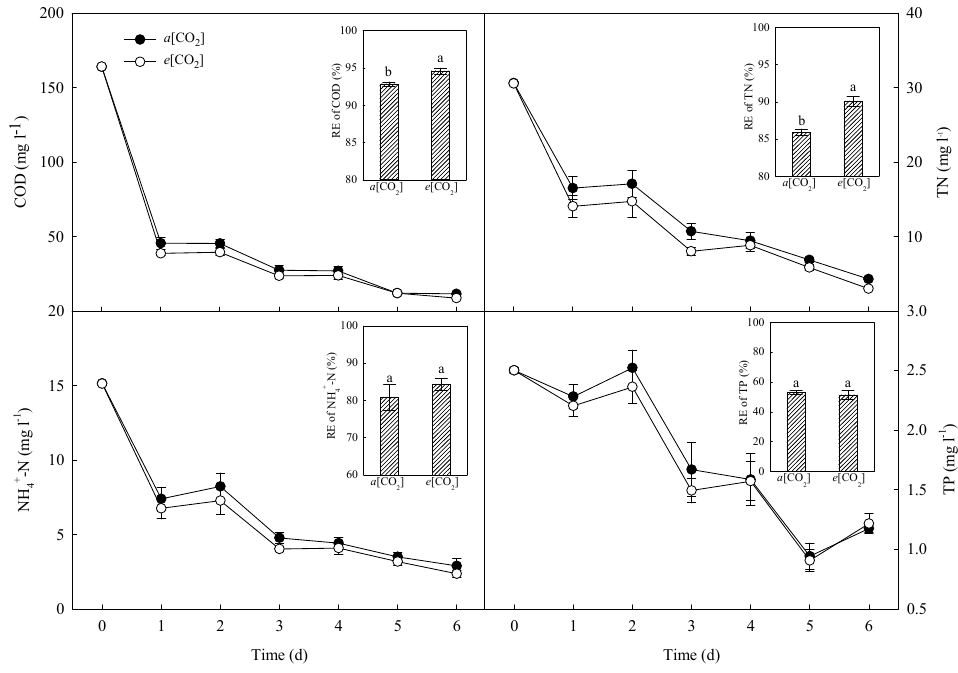
Figure 6. Effluent concentrations and removal efficiency (RE) of chemical oxygen demand, ammonia nitrogen, total nitrogen, and total phosphorus in the constructed wetlands on six consecutive days under ambient ( a [CO 2 ], 400 ppm) and elevated ( e [CO 2 ], 800 ppm) atmospheric CO 2 concentrations. Different small letters mean significant difference at p < 0.05 level. Data are expressed as means ± SEM (n = 3).